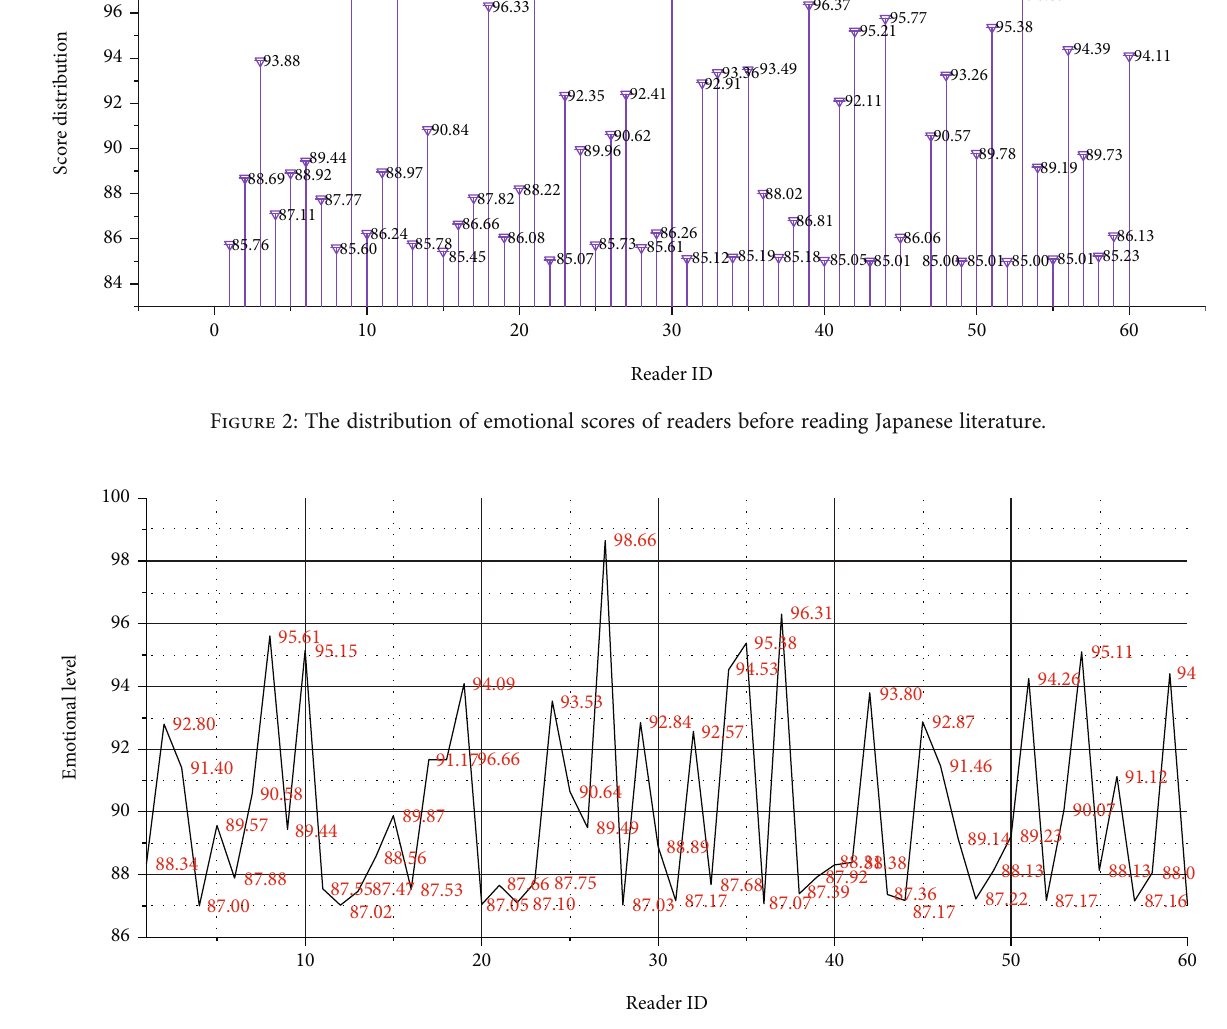
Figure 3: The distribution of readers ’ emotional level in Japanese literature